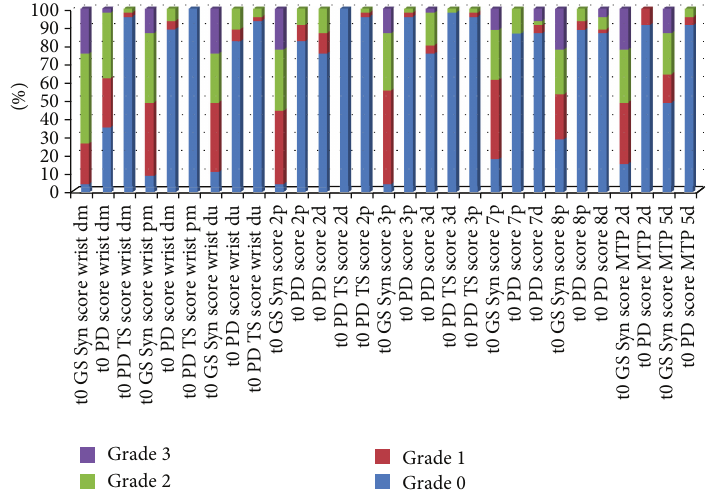
Figure 3: Semiquantitative analysis of each joint region included in the US7 score (without erosions)—baseline (t0). Legend: Syn = synovitis; TS = tenosynovitis/paratenonitis; GS = greyscale; PD = power Doppler; dm = dorsomedian; pm = palmomedian; du = dorsoulnar; 2p = MCP II palmar; 2d = MCP II dorsal; 3p = MCP II palmar; 3d = MCP III dorsal; 7p = PIP II palmar; 7d = PIP II dorsal; 8p = PIP III palmar; 8d = PIP III dorsal.